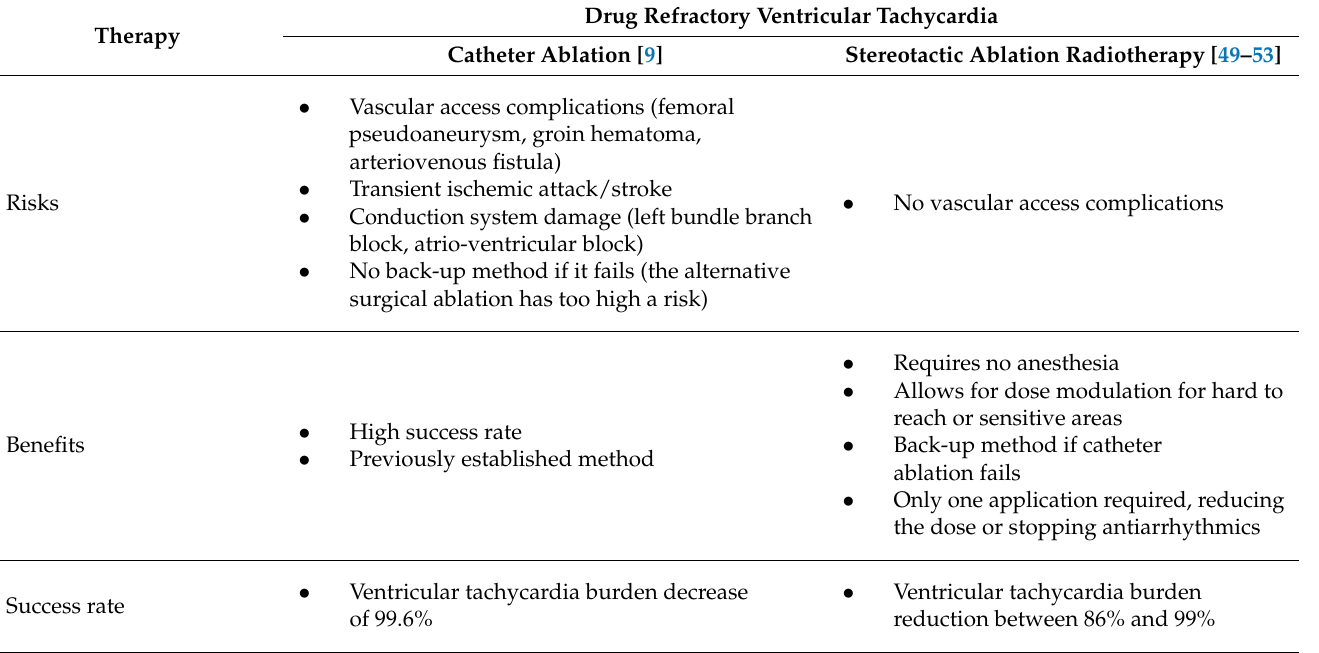
Table 6. Risks and benefits for drug refractory ventricular tachycardia